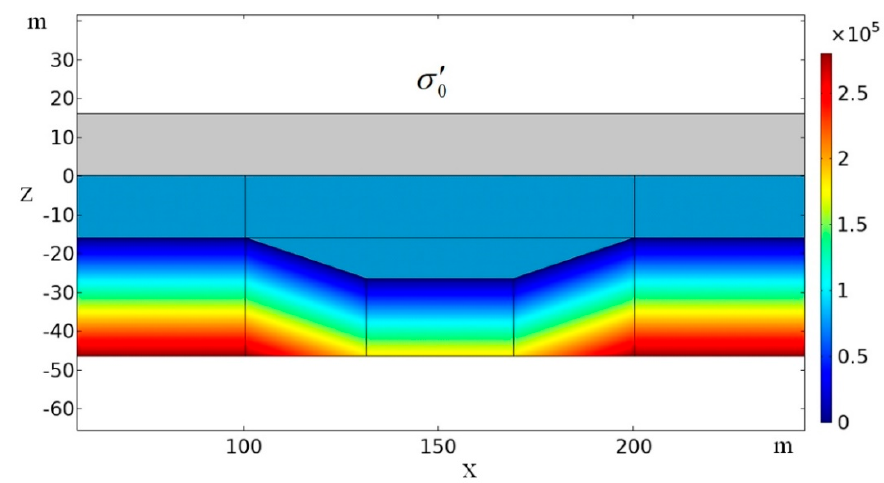
Figure 6. The initial stress distribution after the consolidation of the